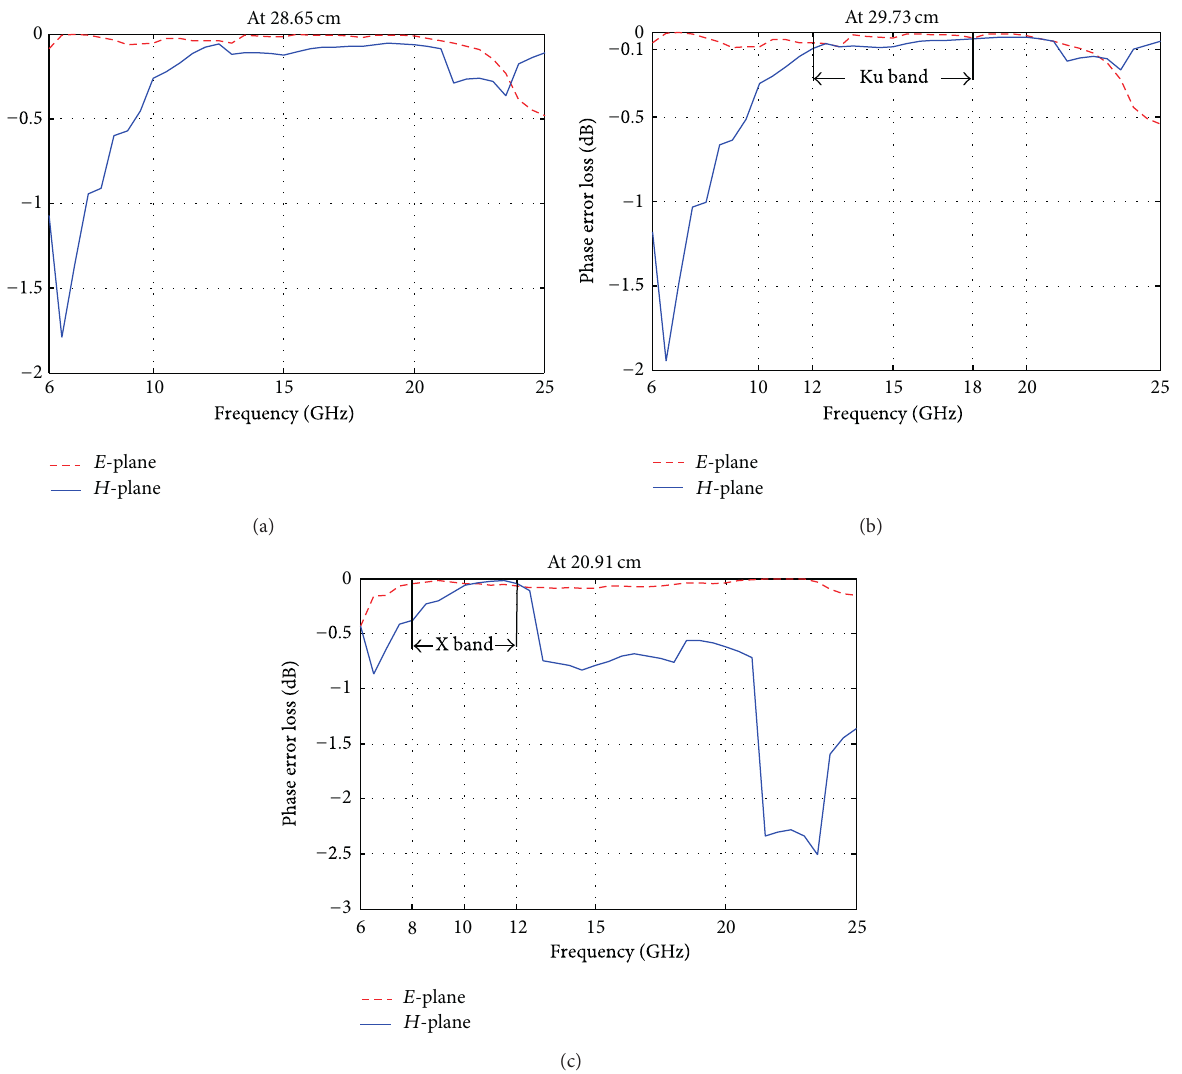
Figure 8: PEL variations after optimization. (a) Whole frequency band (6–25 GHz); (b) Ku band (12–18GHz); (c) X band (8–12 GHz).